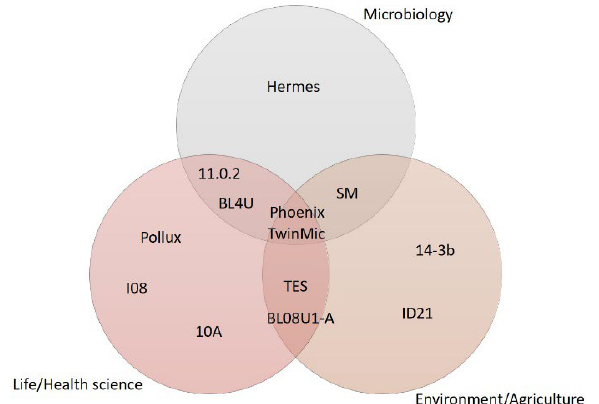
Figure 4. A scheme of the synchrotron beamlines where it is possible to perform soft X-ray micro- spectroscopy in relationship with the three main research fields involving metabolic pathways.